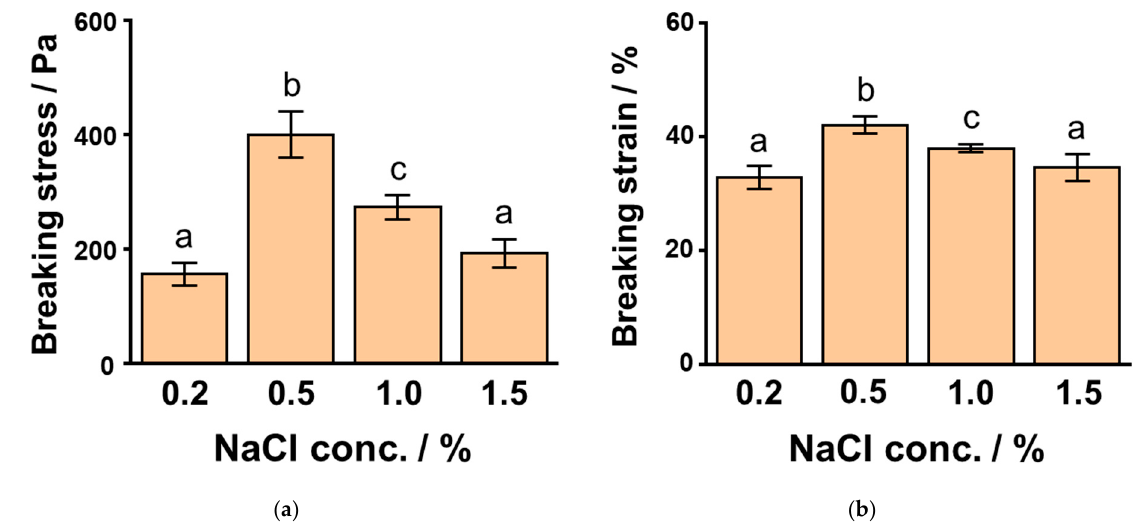
Figure 2. The breaking stress ( a ) and strain ( b ) of 6% soybean protein isolate (SPI) gels at different concentrations of sodium chloride (NaCl). Different letters indicate significant differences ( p < 0.01).